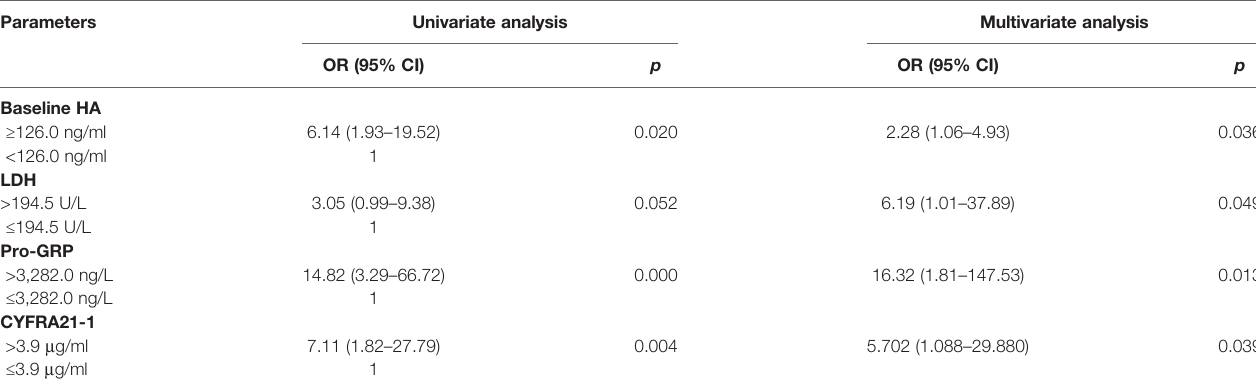
TABLE 1 | Univariate and multivariate logistic regression analyses of variables considered for BM of SCLC